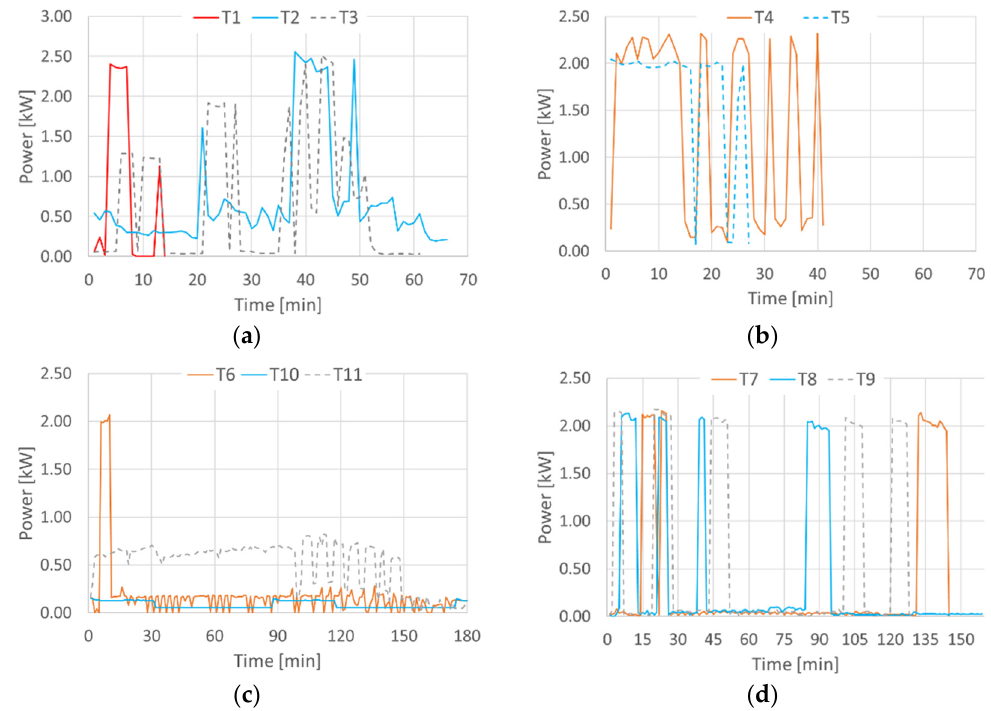
Figure 5. Measurements of electrical absorptions of the different programs of the induction hob ( a ), oven ( b ) base load, washing and dryer machines ( c ) and dishwasher ( d ).